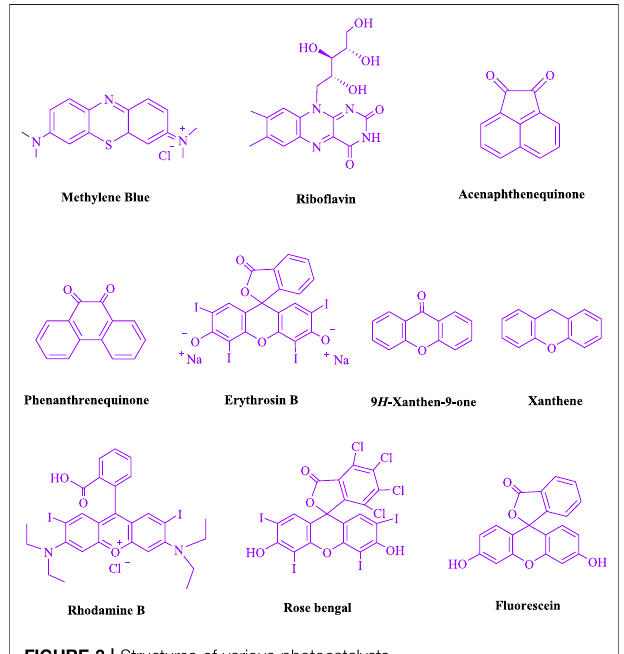
FIGURE 3 | Structures of various Visible light assists Knoevenagel – Michael cyclocondensation process of aldehyde derivatives, malononitrile, and dimedone in an aqueous solvent at room temperature and in an air environment. This was a TABLE 2 | Optimization of the solvents and visible light a .